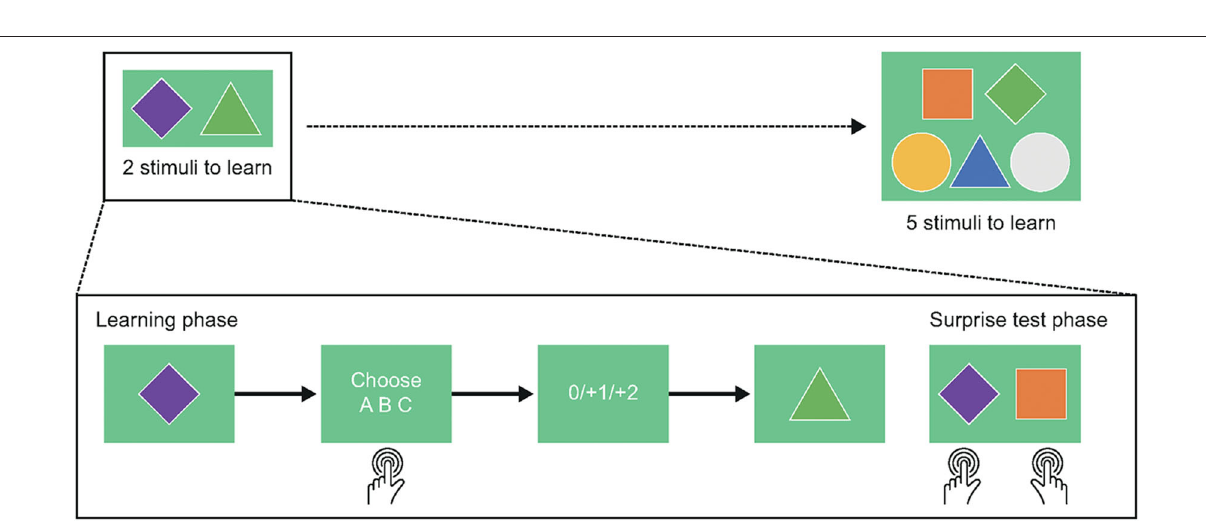
FIGURE 3 | The Reinforcement Learning/Working Memory task. In the Reinforcement Learning/Working Memory task, participants will complete 43 practice trials, 507 learning trials, and 156 test trials, for a total task duration of approximately